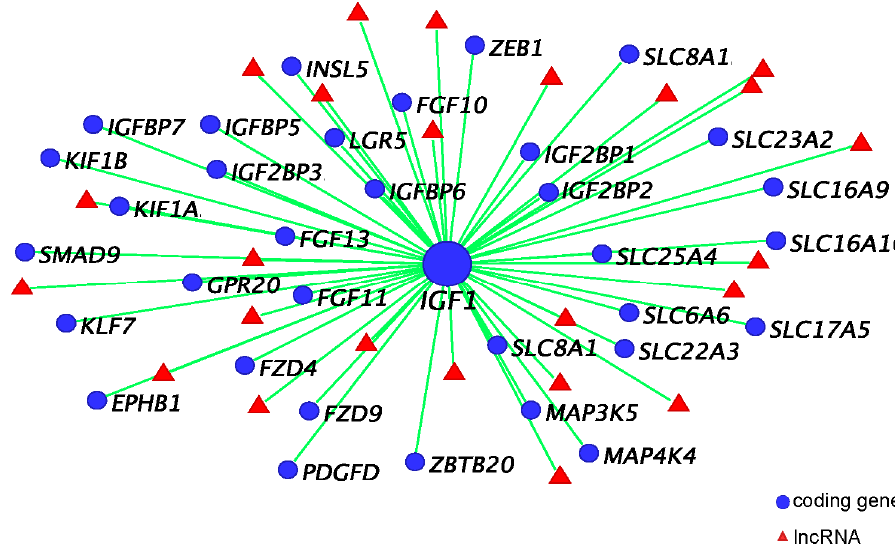
Figure 5. IGF1 , androgen receptor ( AR ), and ESR1 co-expression network. IGF1 co-expressed coding genes (selected based on correlation and reference review) and predicted co-regulatory long non-coding RNAs (R > 0.9). Figure redrawn from [88].